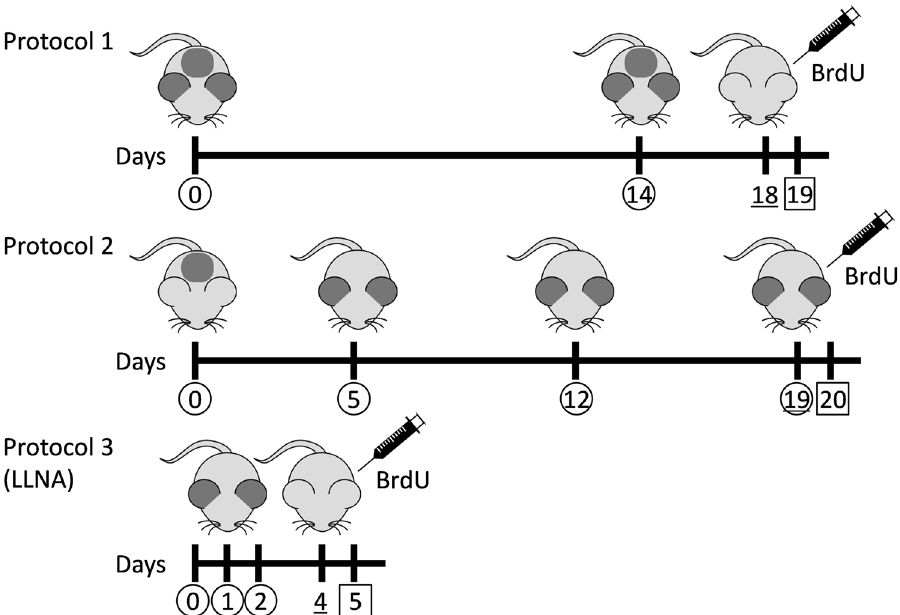
Figure 2. Exposure schedules and procedures for each protocol. Numbers circled, underlined, and squared represent exposure dates to the test substances, BrdU (5-bromo-2 ′ -deoxyuridine) administration periods, and sample collection dates, respectively. The dark-colored areas of the mouse skin are the sites of exposure to the test substance. LLNA local lymph node assay (OECD TG442B). The numbers of animals used in Protocols 1, 2 and 3 were 8, 7 and 10 per group,